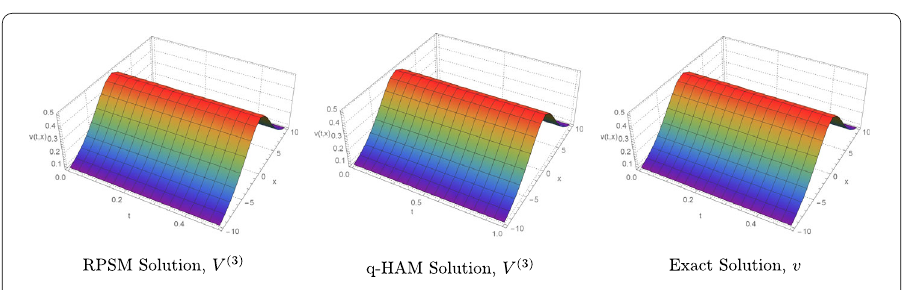
Figure 2 Comparison for Case I: v ( t , x ), λ = 0.5, α =